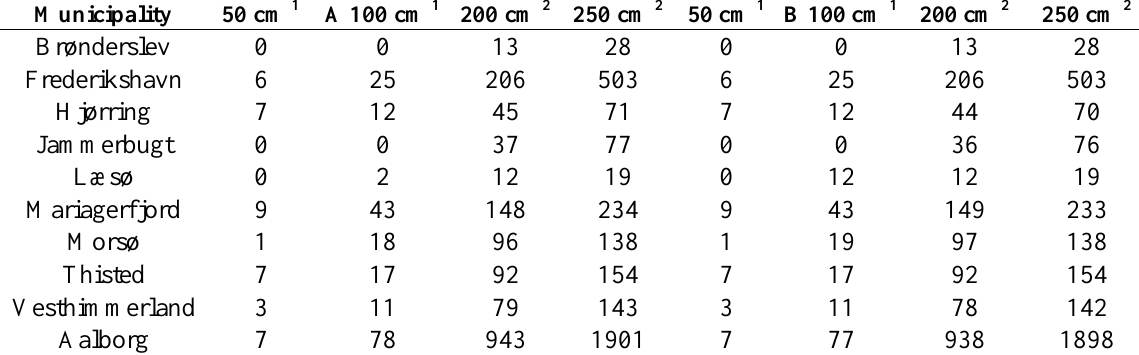
Table 2. Built-up areas (in hectares) inundated under various land-use scenarios (A and B) and water levels due to sea level rise 1 and the combinations of sea level rise and storm surges 2